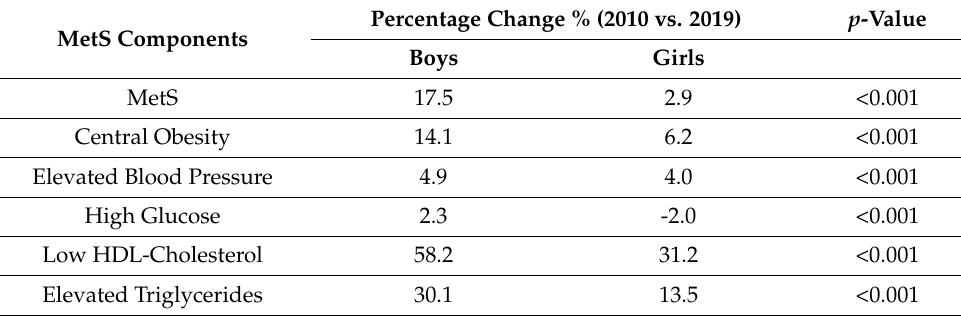
Table 4. Prevalence of MetS components in the 2010, 2015, and 2019